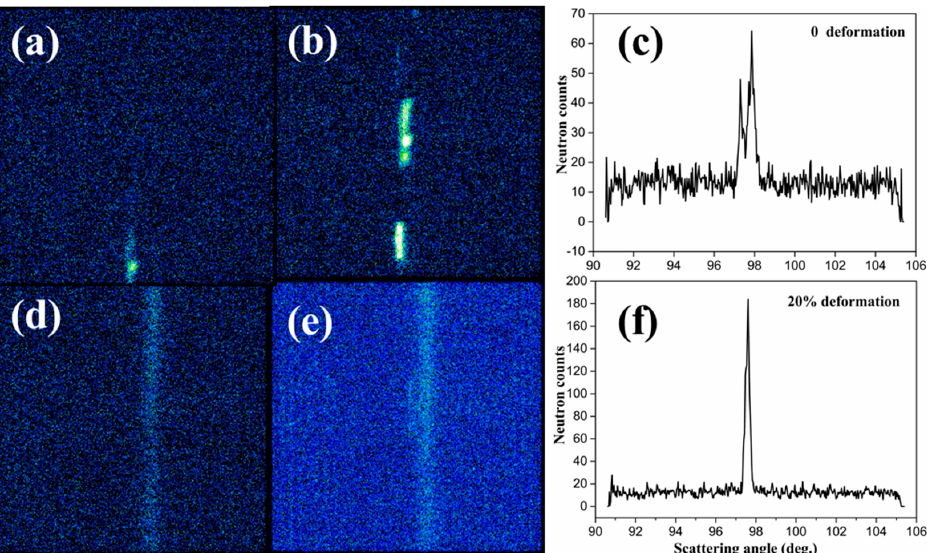
Figure 6. Debye-Scherrer cone of the crystal under approximately ( a ) 0; ( b ) 2%; ( d ) 16% and; ( e ) 20% plastic deformation. The rocking curve measurements for the sample under approximately ( c ) 0 and; ( f ) 20% plastic deformation.